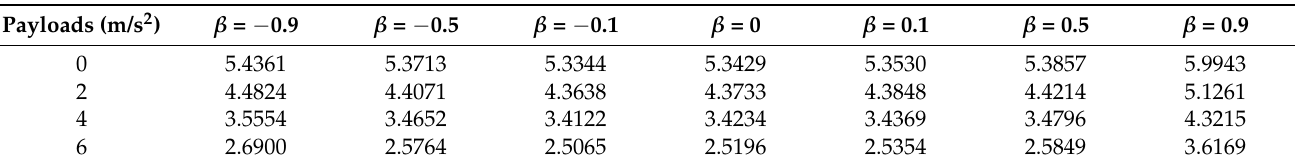
Table 4. Root mean squared value of the control signal u 1 in the first 30 s under different payloads and different fractional orders in the proposed controller.